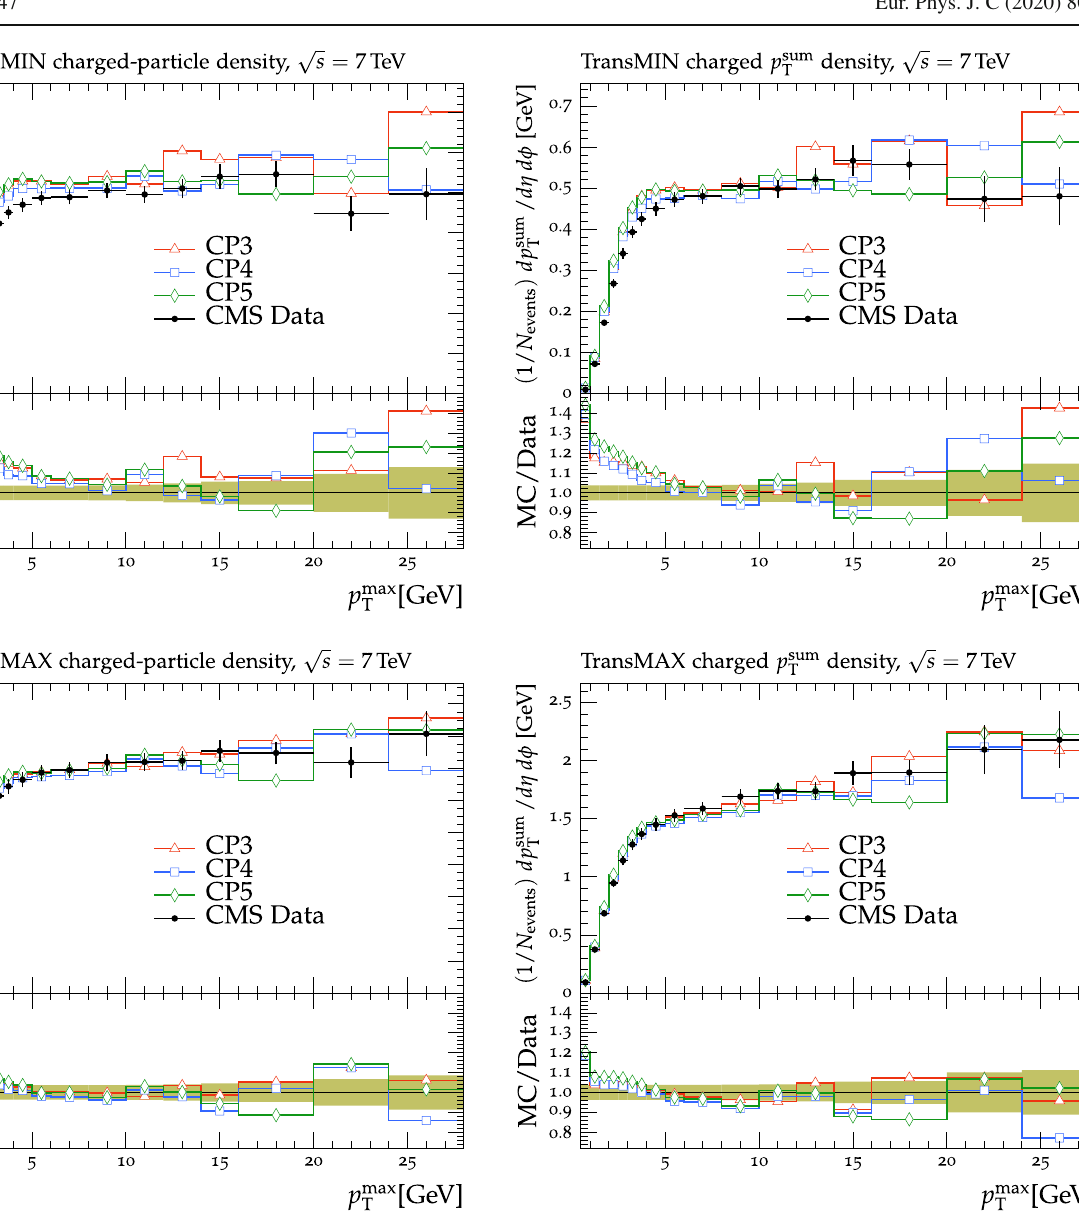
pythia 8 (N)NLO-PDF tunes CP3, CP4, and CP5. The ratios of simu- Fig. 7 The transMIN (upper left) charged-particle and charged p sum T lations to the data (MC/Data) are also shown, where the shaded band (upper right) densities and the transMAX (lower left) charged-particle indicates the total experimental uncertainty in the data. Vertical lines and charged p sum (lower right) densities, as a function of the trans- T drawn on the data points refer to the total uncertainty in the data. Ver- verse momentum of the leading charged particle, p max , from the √ T s = 7TeV analysis [10]. Charged hadrons are measured with tical lines drawn on the MC points refer to the statistical uncertainty in CMS p T > 0 . 5GeV in | η | < 0 . 8. The data are compared with the CMS the predictions. Horizontal bars indicate the associated bin